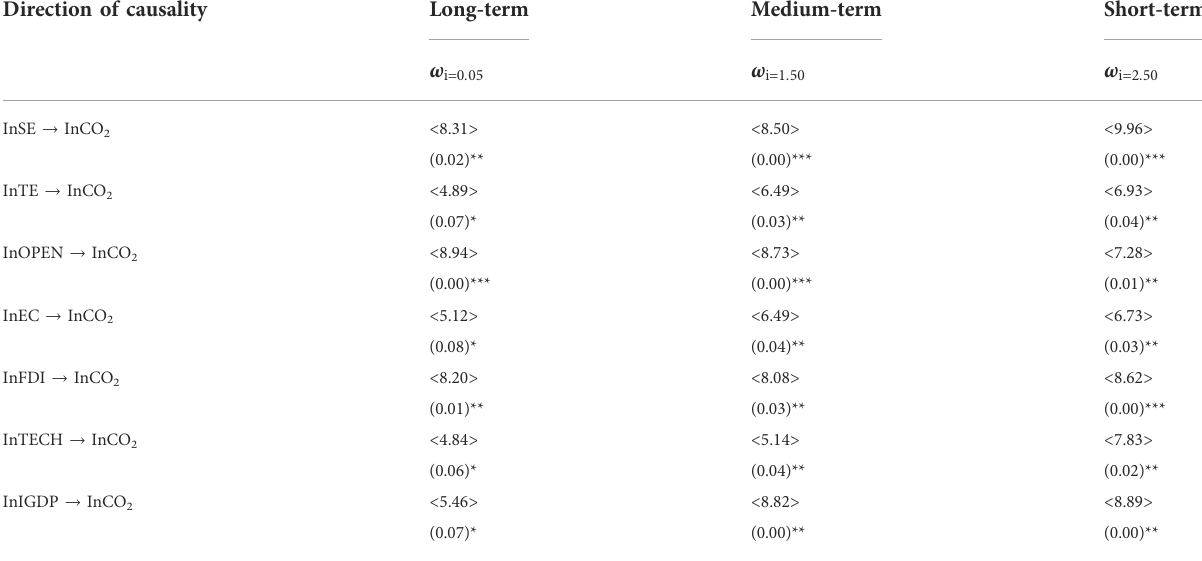
TABLE 8 Frequency-domain causality